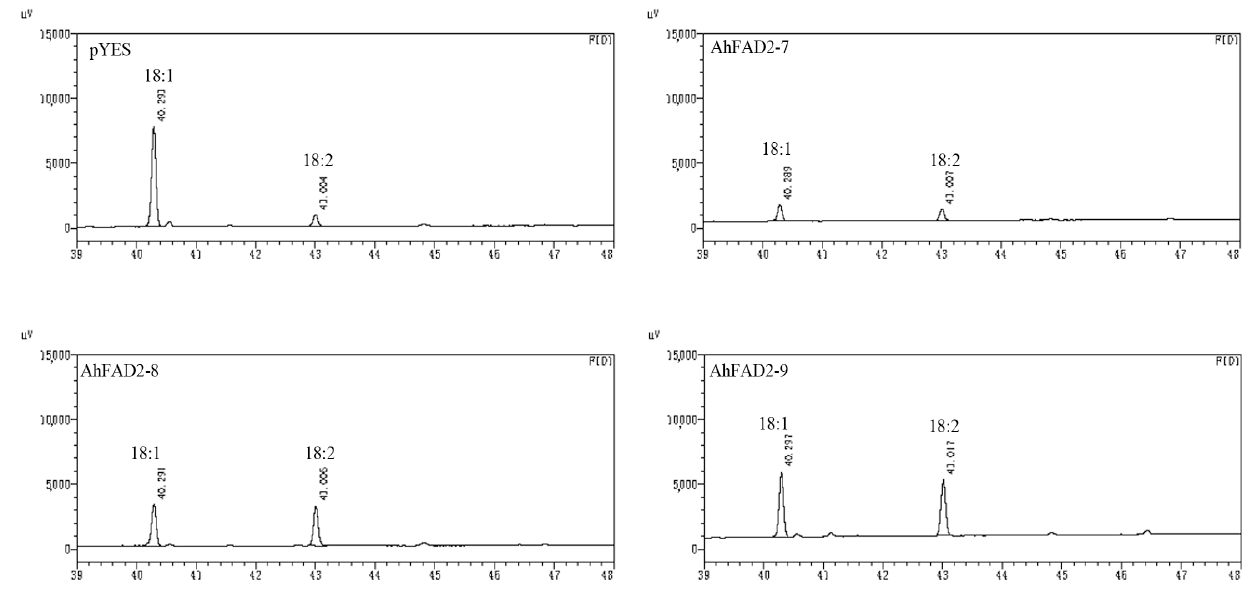
Figure 5. GC-MS of yeast cultures. pYES2 (control), pYFAD2-7 (pYES2 transformed with AhFAD2-7), pYFAD2-8 (pYES2 transformed with AhFAD2-8), and pYFAD2-9 (pYES2 transformed with AhFAD2-9). C18:1, oleic acid; C18:2, linoleic acid. Table 1. Fatty acid composition of transformed S. cerevisiae INVSc1. Transformant Oleic Acid (%)